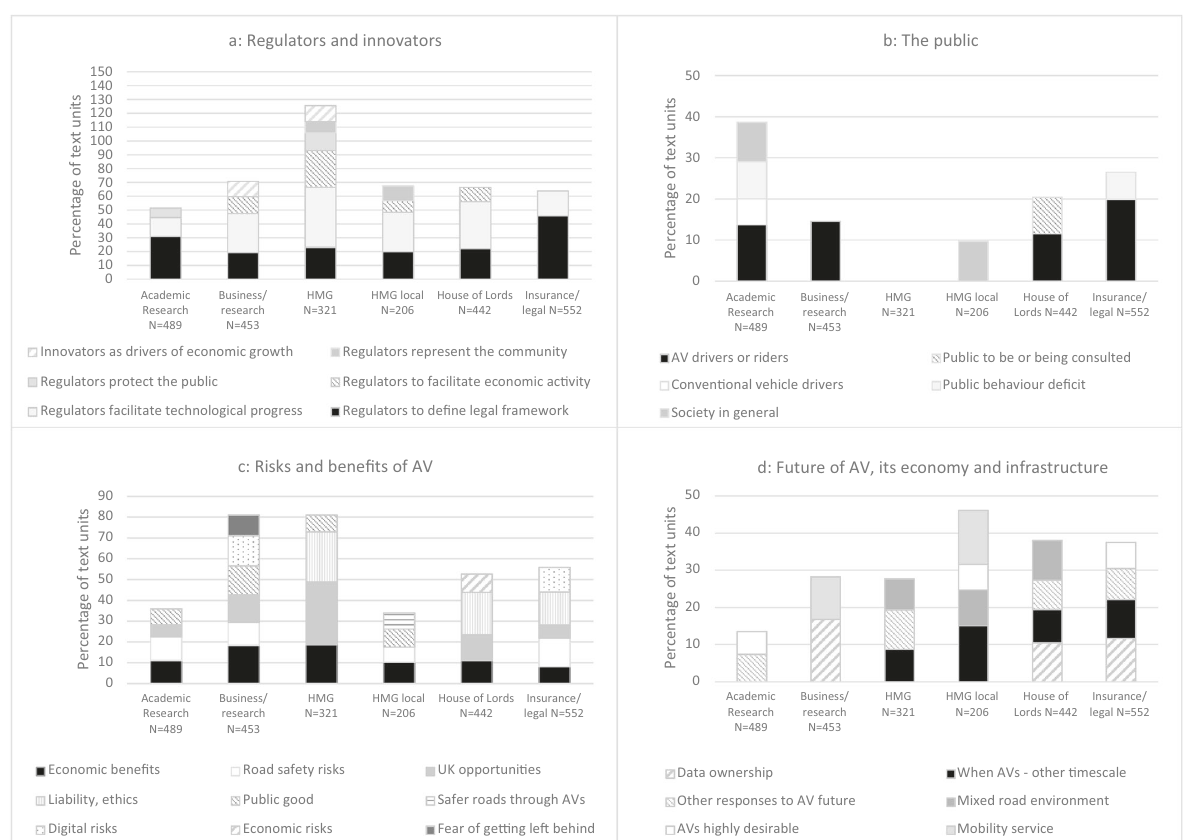
Fig. 2 Most mentioned detailed themes (subsidiary codes) for top 6 classes of